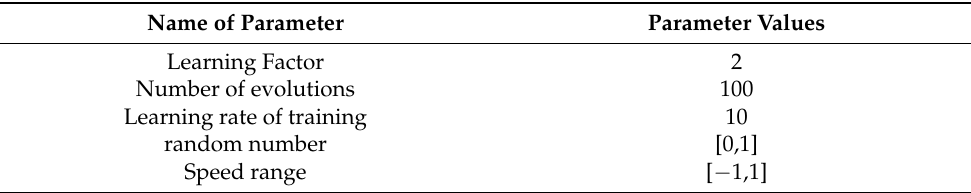
Table 5. The parameters of the PSO-BP integrated model.